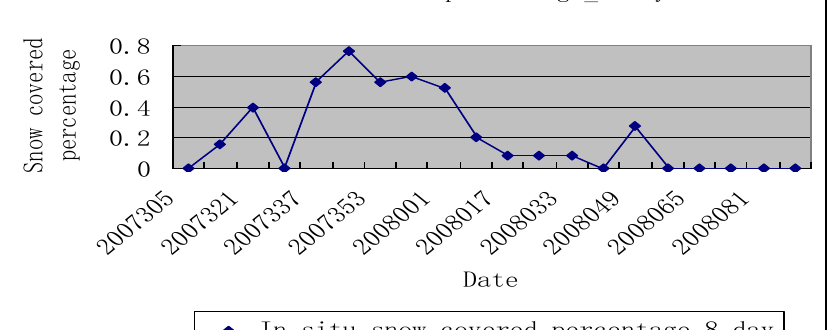
In situ snow covered percentage_8